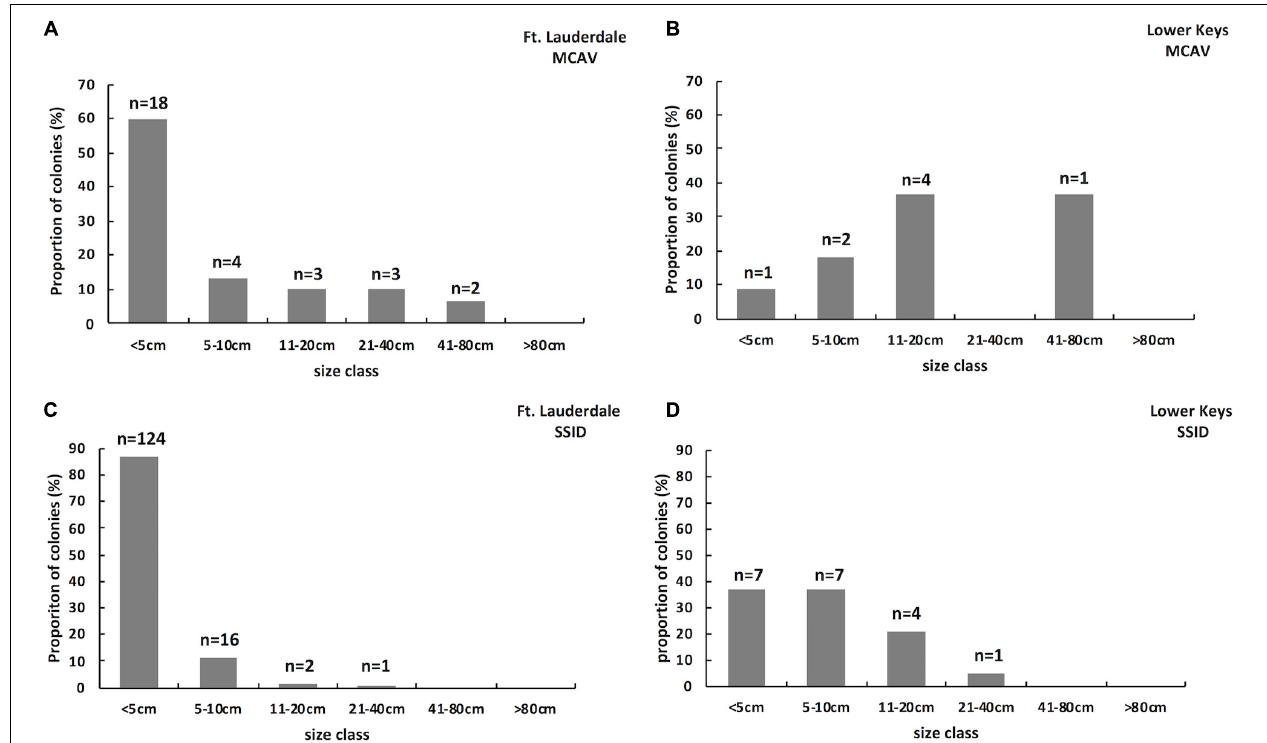
FIGURE 2 | Size class structure of M. cavernosa on a reef (Fort Lauderdale) in an endemic SCTLD zone ( n = 30; A) and on a reef (Lower Keys) in a zone where SCTLD just emerged ( n = 11; B) . Size class structure of S. siderea on a reef (Fort Lauderdale) in an endemic SCTLD zone ( n = 143; C) and on a reef (Lower Keys) in a zone where SCTLD just emerged ( n = 19; D) .